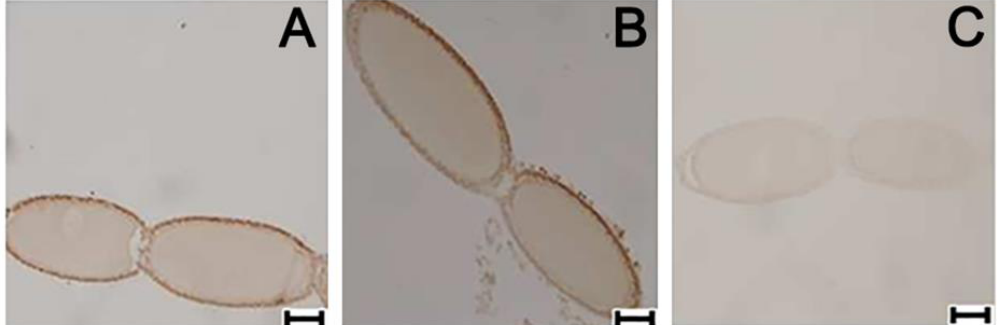
Figure 7. Immunocytochemical detection of VgR in P. americana ovaries from virgin female by immunofluorescence. Control ( A ), CCAP injected ( B ) and sNPF injected ( C ) of normally fed insect 4 days after injection. Scale bar = 200 μm.